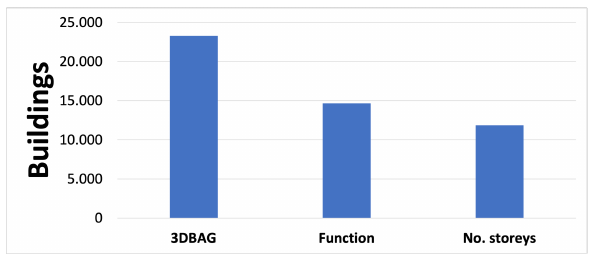
Figure 2. Summary of the initial three input datasets